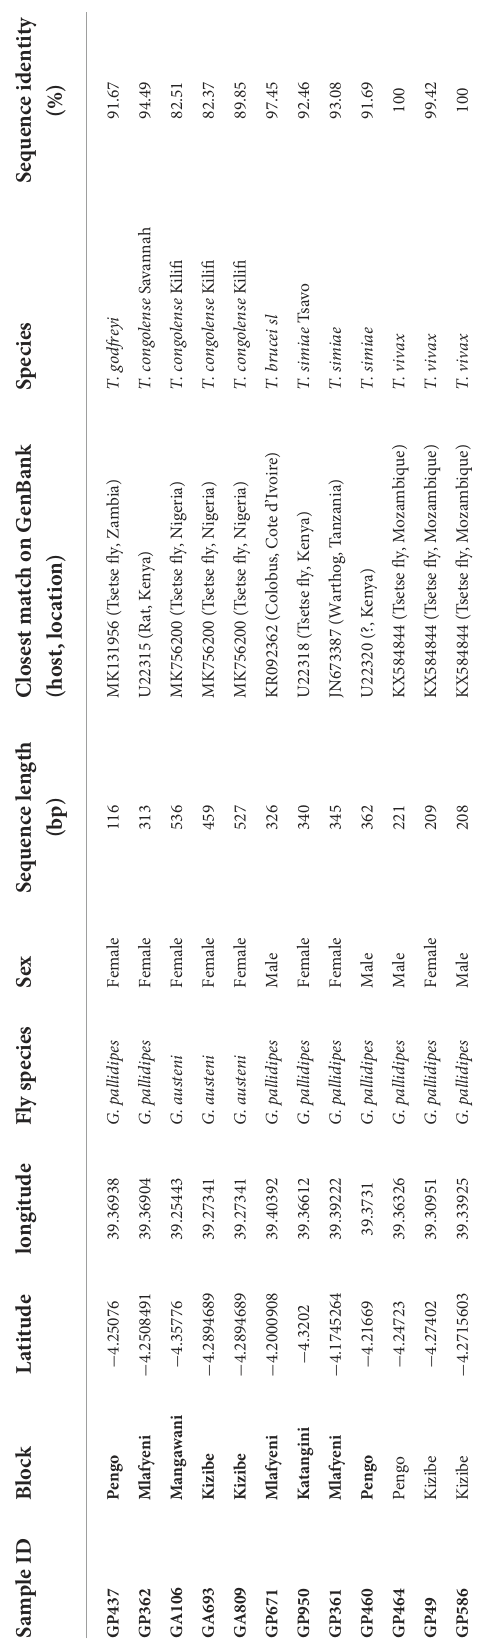
a 15 µ L reaction-volume containing, 2 µ L template DNA, 3 µ L of 5X HOT FIREPol R (cid:13) Blend Master Mix (Solis BioDyne, Tartu, Estonia). Cycling conditions for the amplification were: initial denaturation for 15 min at 95 ◦ C, followed by 40 cycles of denaturation at 95 ◦ C for 20 s, annealing at 57 ◦ C for 30 s, and extension at 72 ◦ C for 60s, followed by a final extension at 72 ◦ C for 7 min. The success